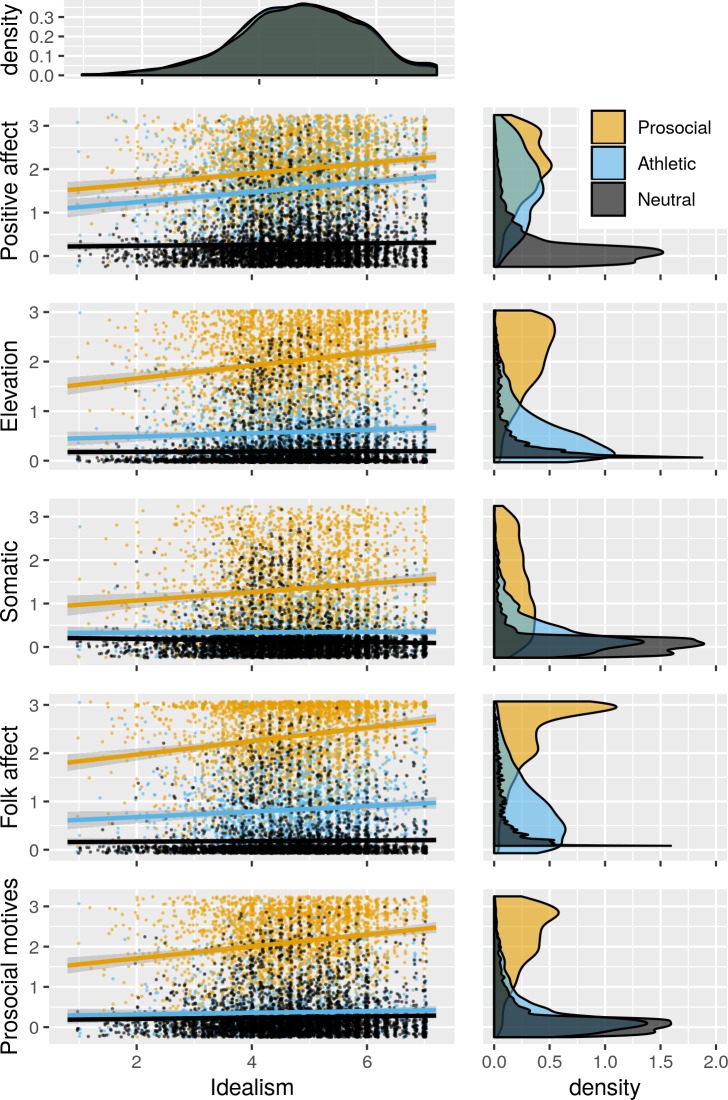
Emotion as a function of idealism and condition.Emotion measures include general positive affect, elevation, and three elevation subscales. Data pooled from 13 relevant studies (total observations: Neutral = 5040, Athletic = 2454, Prosocial = 2619).